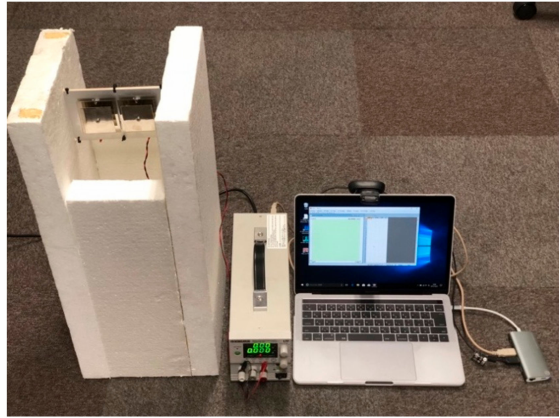
Figure 5. A prototype system of the proposed adaptive array antenna (AAA) system.